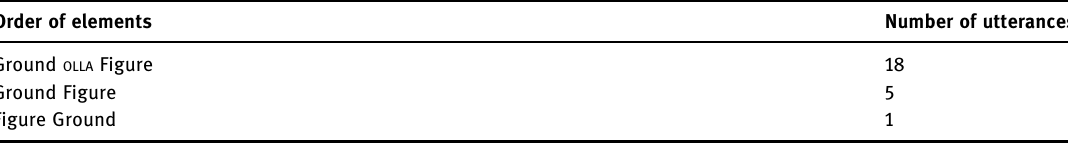
Table 2: A summary of the order of Figure and Ground when Figure is new ( room setting 2 )